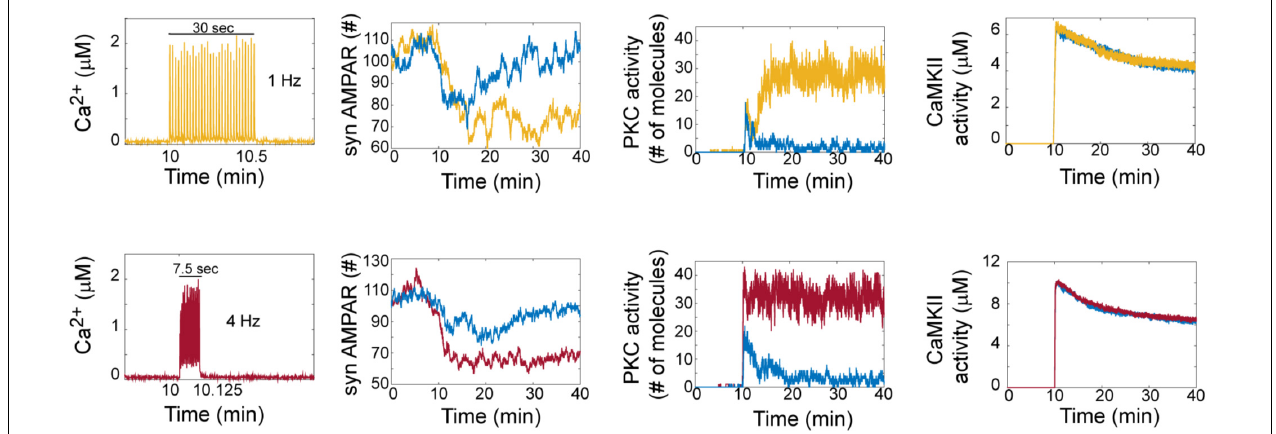
FIGURE 2 | LTD signaling network is bistable. Molecular network activity over time with thirty Ca 2 + pulses as stimulus at 10 min at frequecies of 1 Hz and 4 Hz. Ca 2 + , AMPAR, PKC, and CaMKII activity over time at 1 Hz (yellow train of Ca 2 + pulses) and 4 Hz (red train of Ca 2 + pulses). Blue color represents the dynamic of non LTD